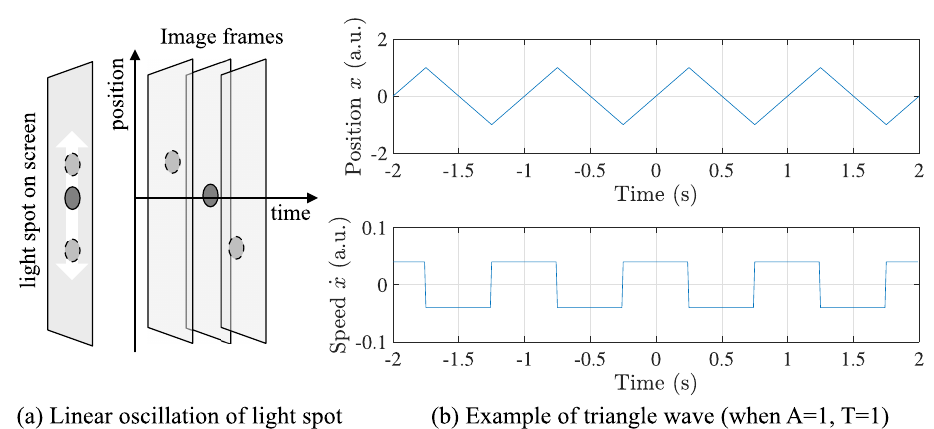
Figure 2. Linear oscillation of light spot and triangle wave. ( a ) The position of light spot linearly oscillating on a screen produces ( b ) a triangle wave in spatiotemporal space. In the triangle wave, the temporal positions of peak points play the key role to evaluate the frame synchronization quanti- tatively, which is equivalent to the edges of the square wave as the differential of the triangle